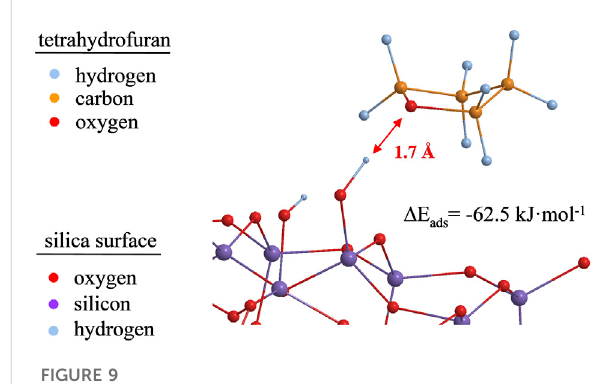
FIGURE 9 Optimized geometry for tetrahydrofuran adsorbed on silanol groups of a 32 Si-member silica cluster model at the B3LYP/6-31G (d,p) level of theory. For reasons of demonstrability, protons at the silica cluster ’ s boundaries are